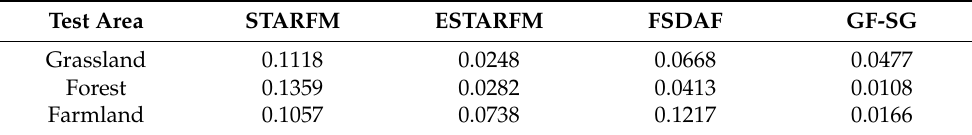
Table 1. RMSE of the fusion results of different methods.